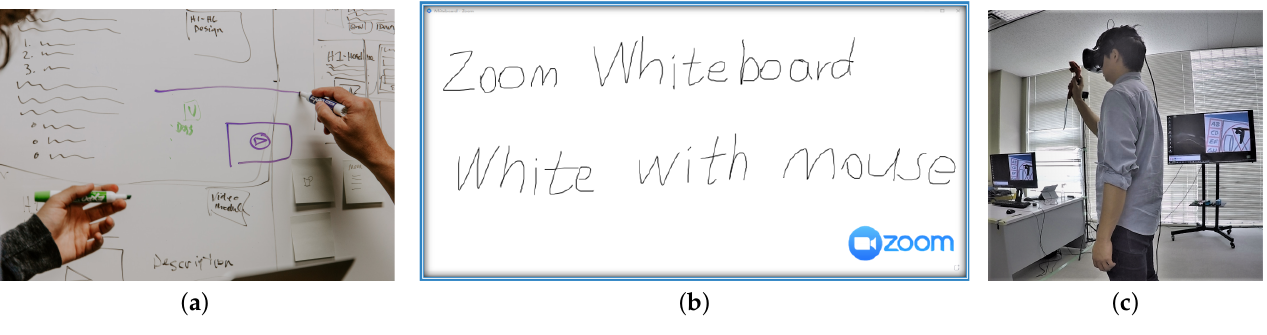
Figure 1. Collaborative whiteboards. ( a ) Collaborate locally using the traditional whiteboard; ( b ) Collaborate remotely using the electronic whiteboard; ( c ) Use of the HMD and controller (VR